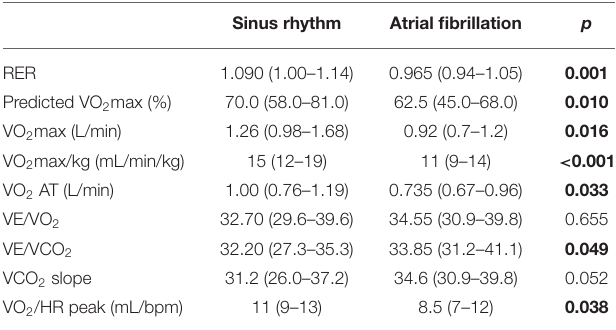
TABLE 4 | Analysis of CPET variables in AF and non-AF